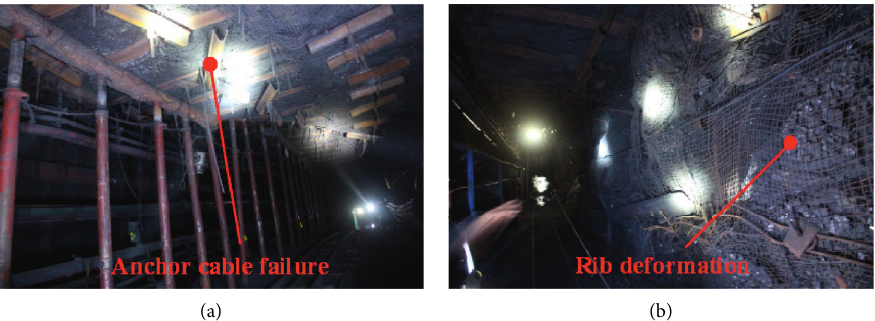
Figure 15: Deformation characteristics of the entry in San coal mine in Yangquan coal field. (a) Anchor cable failure. (b) Rib deformation.